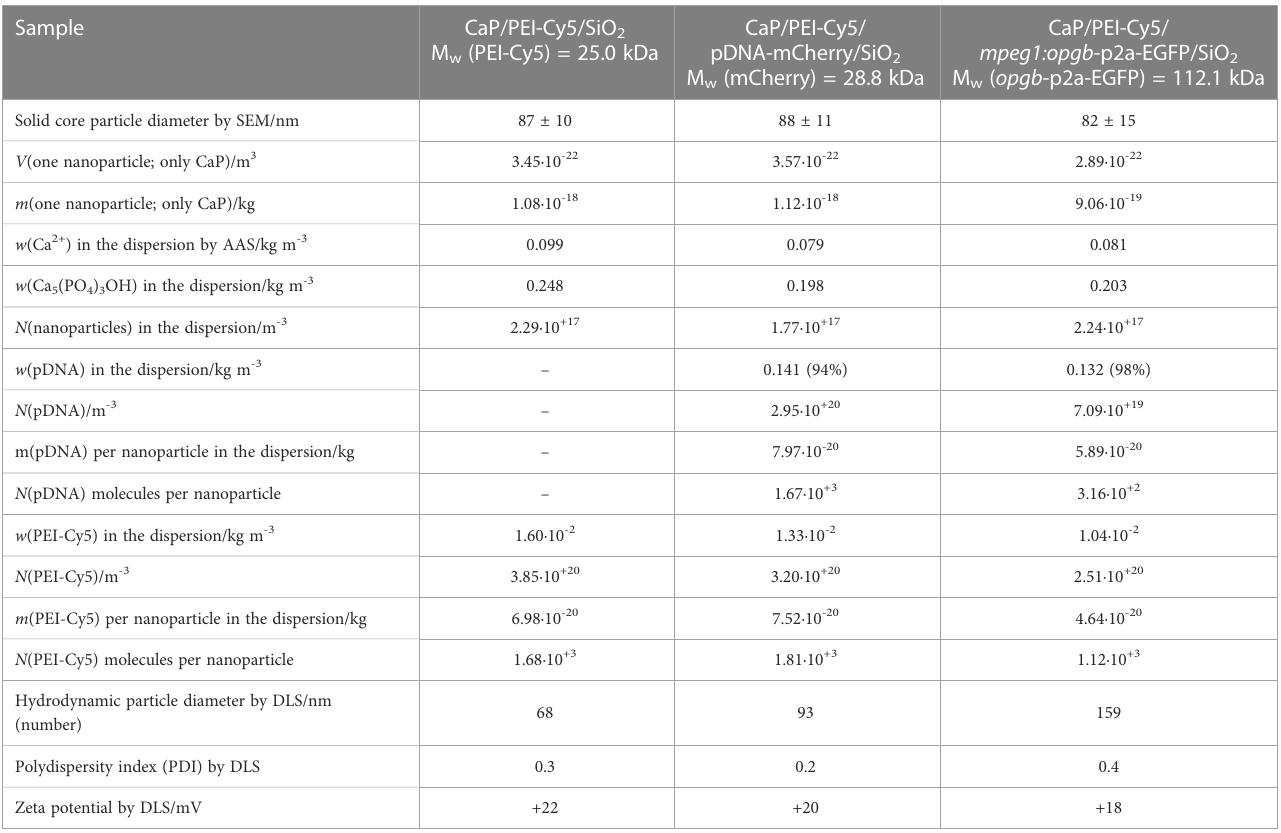
TABLE 1 Characterization of nanoparticles.